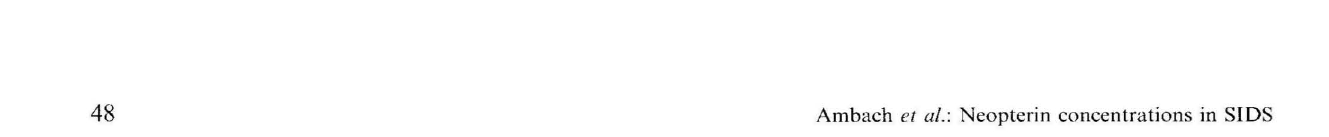
Table 1. Post mortem neopterin and creatinine concentrations in cases with and without signs of inflammatory disorders (n; median; 25th - 75th percentile)